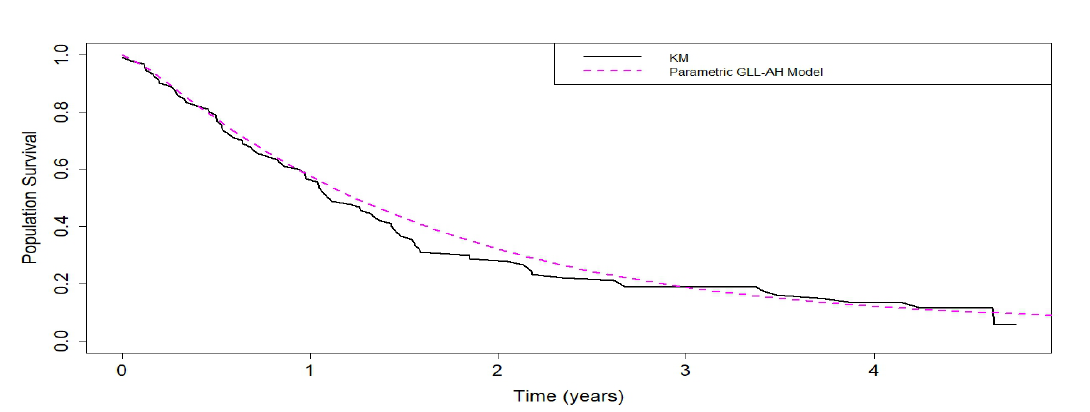
Figure 13. Kaplan–Meier and fitted survival curve for the GLL–AH model of the gastric cancer dataset.